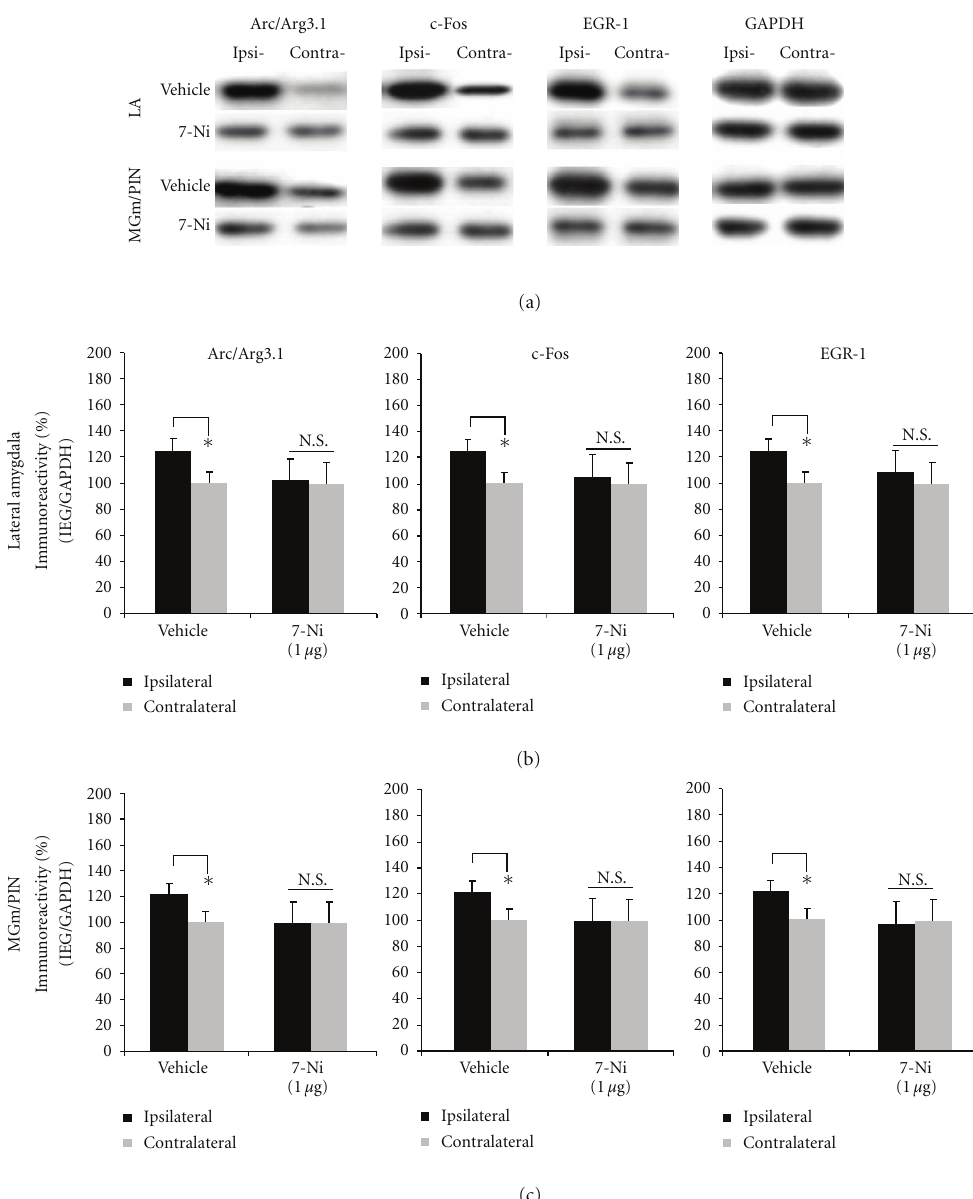
Figure 7: Pharmacological blockade of NOS activation in the LA impairs ERK-driven IEG expression in both LA and MGm/PIN following HFS. (a) Images of Western blots for Arc/Arg3.1, c-Fos, EGR-1 and GAPDH from both LA (top) and MGm/PIN (bottom) samples. (b) Mean ( ± SEM) percent Arc/Arg3.1, c-Fos and EGR-1 immunoreactivity from LA punches taken from rats given intra-LA infusion of 50% DMSO (vehicle; n = 8) or 1 μ g/side 7-Ni ( n = 8). (c) Mean ( ± SEM) percent Arc/Arg3.1, c-Fos and EGR-1 immunoreactivity from MGm/PIN punches taken from rats given intra-LA infusion of 50% DMSO (vehicle; n = 8) or 1 μ g/side 7-Ni ( n = 8). In each figure, IEG levels have been normalized to GAPDH for each sample, and IEG expression on the ipsilateral side has been expressed as a percentage of that on the contralateral side for each rat. ∗ P < . 05 relative to the ipsilateral side N.S. = not significant.